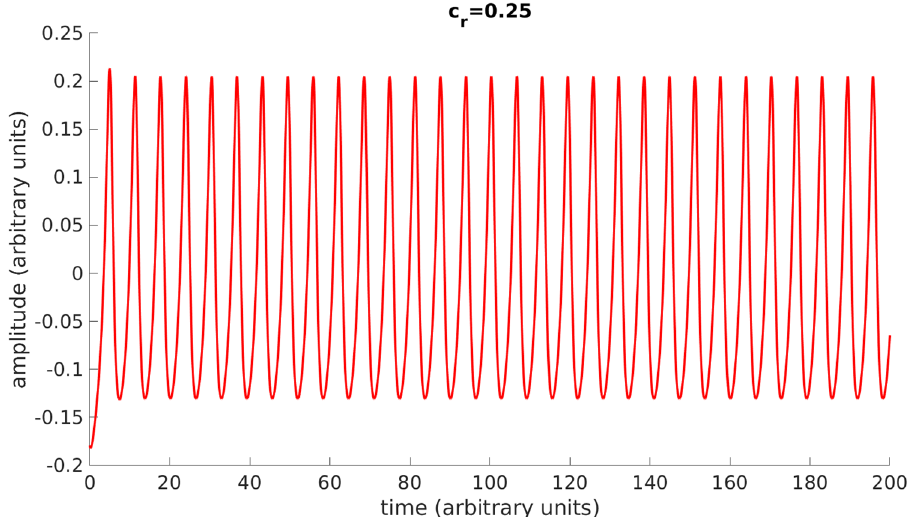
Figure 7. The amplitude and phase of a single mode for c r = 0.25 .